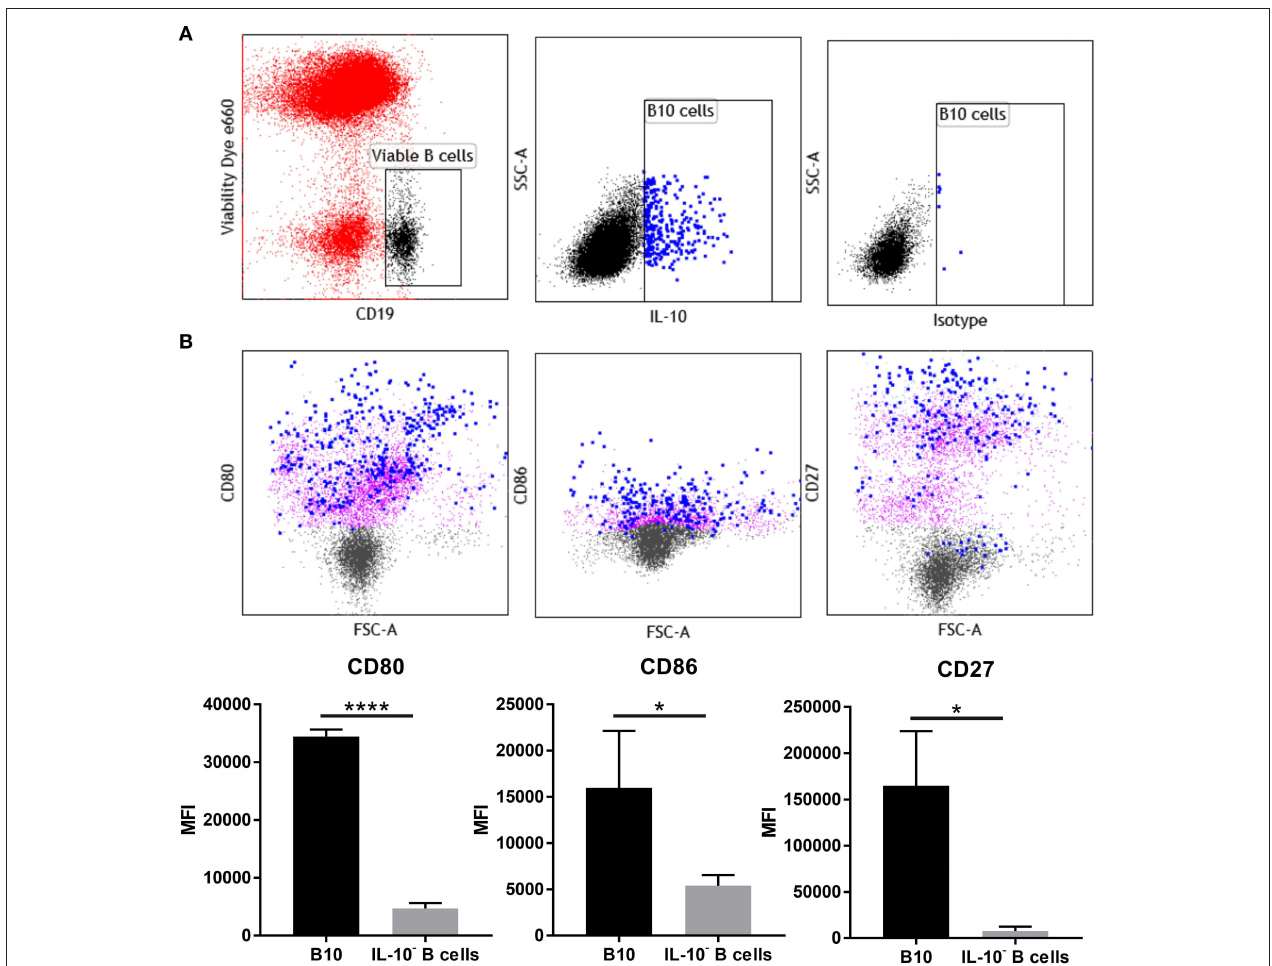
FIGURE 5 | IL-10 + B cells at day 5.5pc have upregulated expression of CD27, CD80, and CD86. (A) Gating strategy for IL-10 + cells within the viable CD19 + cell population. (B) Representative flow cytometric profiles of B10 cells (blue) and IL-10 − B cells (purple) and their upregulated expression of activation marker CD27 and co-stimulatory molecules CD80 and CD86, and the corresponding graphical presentation of the mean fluorescence intensity (MFI) of B10 cells compared to IL-10 − B cells by unpaired t -test. * p ≤ 0.05, **** p ≤ 0.0001. Data shown are from three independent